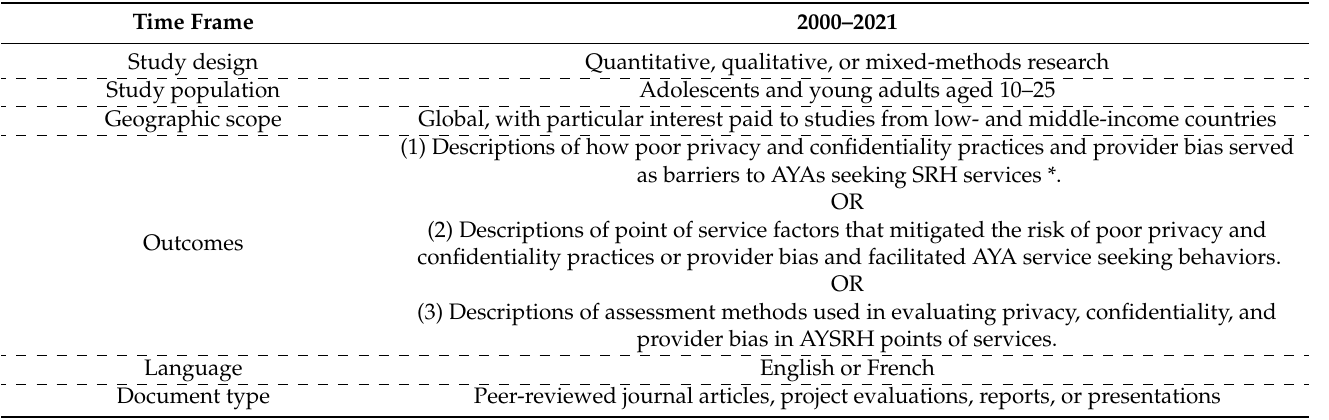
Table 1. Inclusion